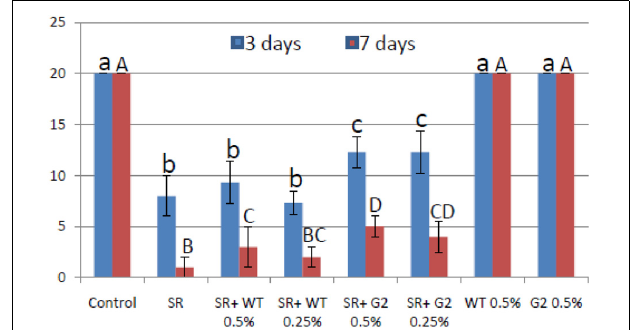
FIGURE 11 | Pot assay for biocontrol of Sclerotium rolfsii in chickpea treated with wild type or mutant, in the presence and absence of the pathogen. Treatments with same letters (case-sensitive) are not significantly different ( P < 0.05).